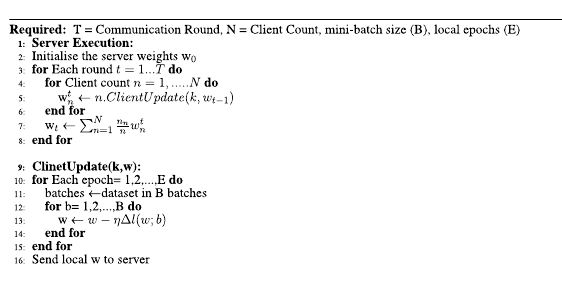
Algorithm 1. Model Aggregation Algorithm in VFWN.